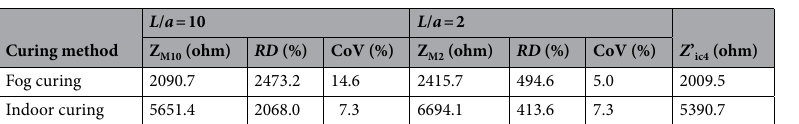
Table 8. Contact impedance evaluated by the two-point measurement with precast titanium bar electrodes. Z M10 and Z M2 mean the two-point measurement impedance of samples with L / a = 10 and 2, respectively, with precast titanium bars as both current and voltage electrodes. Z ’ ic4 means the contact impedance between the voltage electrodes and the oven-dried sample in the four-point measurement; RD means the relative deviation of the contact impedance measured by the two-point measurement to pure sample impedance. CoV means the variation coefficient of the test results of the three